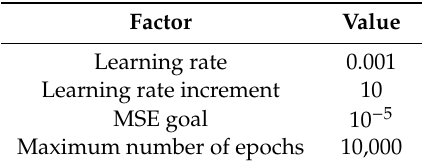
Table 3. Main factors of ANN being implemented.